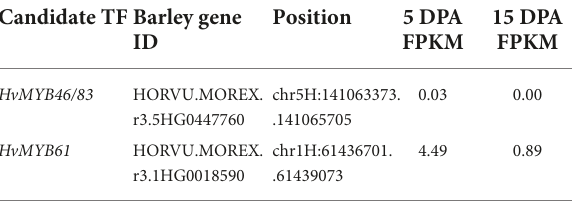
TABLE 2 Description of candidate transcription factors retrieved from GrainGenes (https://wheat.pw.usda.gov/GG3/) based on cv. MorexV3 (Mascher et al., 2021)